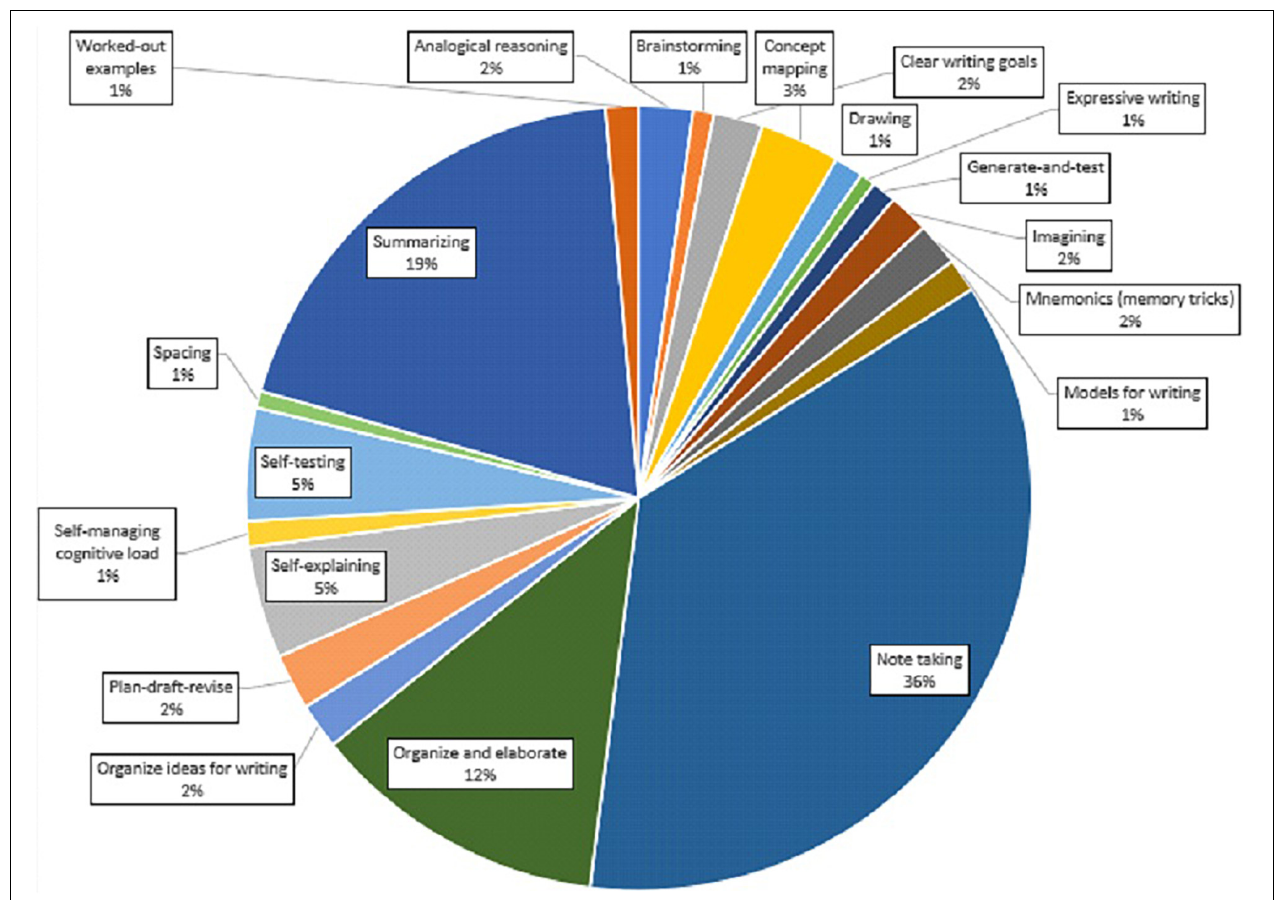
FIGURE 8 | A pie chart showing the percentage for each strategy’ in the total of strategy’